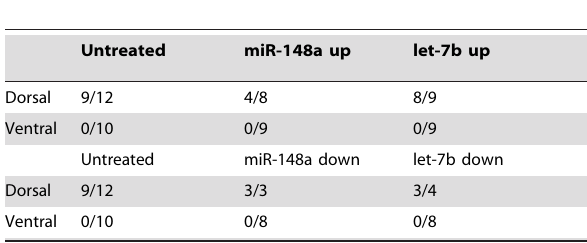
Table1. Ratio of lens regeneration from gain or loss of function of miRNAs in PECs.